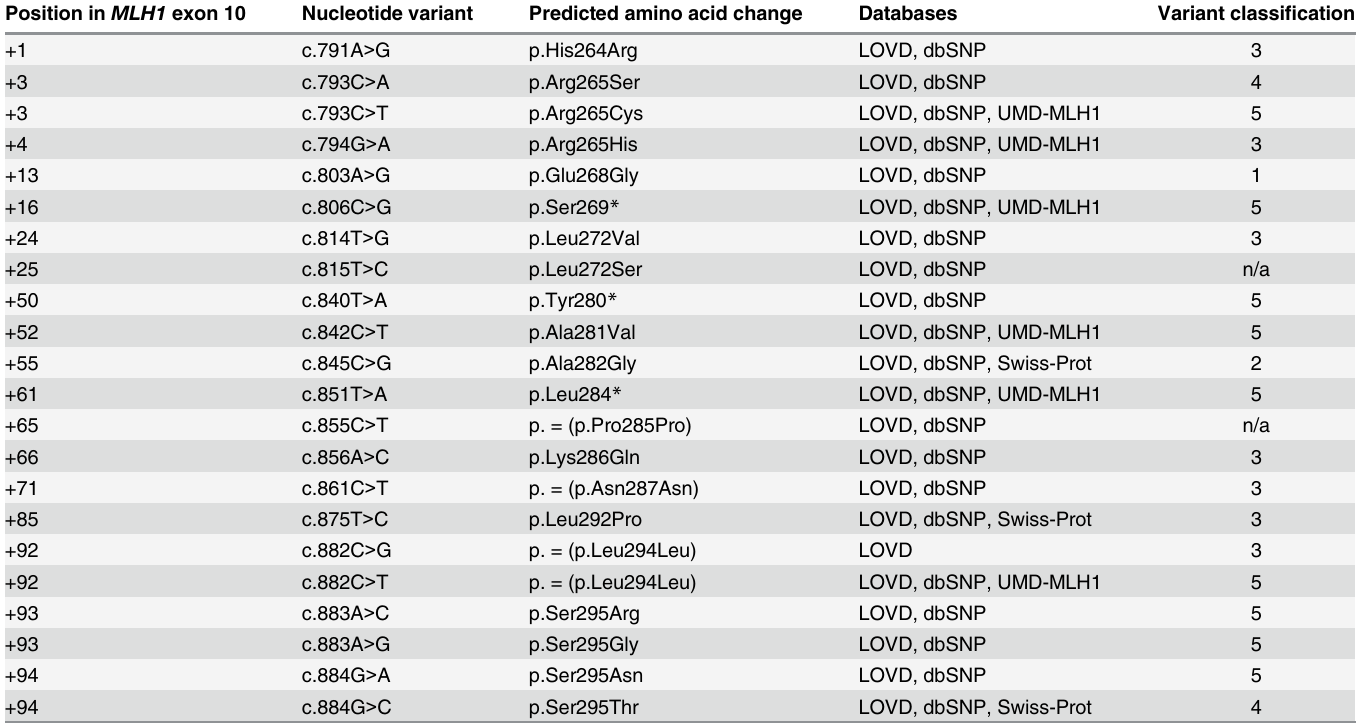
Table 1. MLH1 exon 10 variants analyzed in this study. MLH1 exon 10 spans nucleotide positions c.791 to c.884. The first and the last 3 exonic positions (delineated by the dashed line) are an integral part of the 3 ’ ss and 5 ’ ss consensus sequences, respectively. LOVD, Leiden Open Variation Database; dbSNP, the Single Nucleotide Polymorphism database; UMD-MLH1, Universal Mutation Database-MLH1; Swiss-Prot, the European protein sequence data- base. Variant classification was retrieved from the LOVD database and refers to the 5-tier system used by the InSiGHT Variant Interpretation Committee (http://insight-group.org/variants/classifications/) as follows: 1, not pathogenic; 2, likely not pathogenic; 3, uncertain; (also called VUS for variants of unknown significance); 4, likely pathogenic; 5, pathogenic; n/a, not